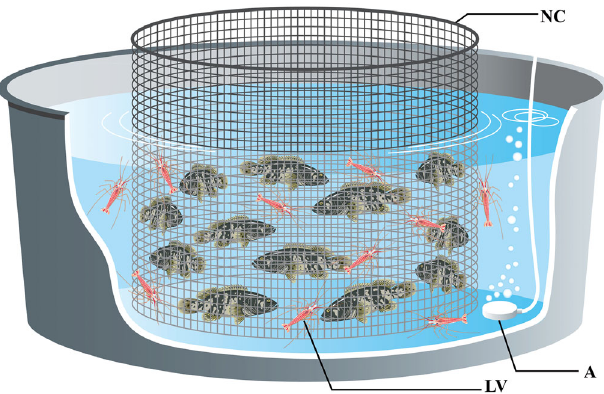
Fig. 2. Graphic representation of a replicate treatment tank containing juvenile Epinephelus lanceolatus inside oyster mesh net cages (NC), and Lysmata vittata (LV) on the out side of the cages. A: constant